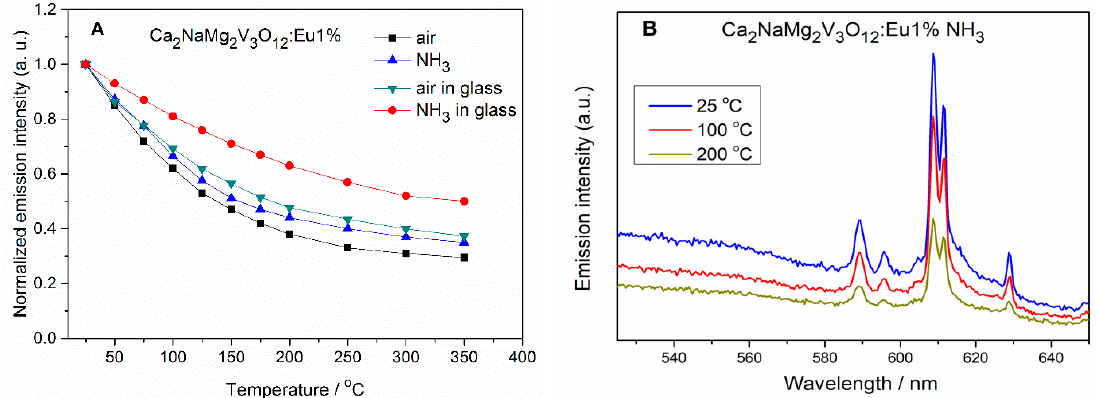
Figure 5. ( A ) Temperature dependence of the integrated emission intensity of Ca 2 NaMg 2 V 3 O 12 : Eu (1%) obtained in different atmospheres and as respective PiG phosphor. ( B ) Temperature dependence of the Eu 3+ emission intensity for three different temperatures.